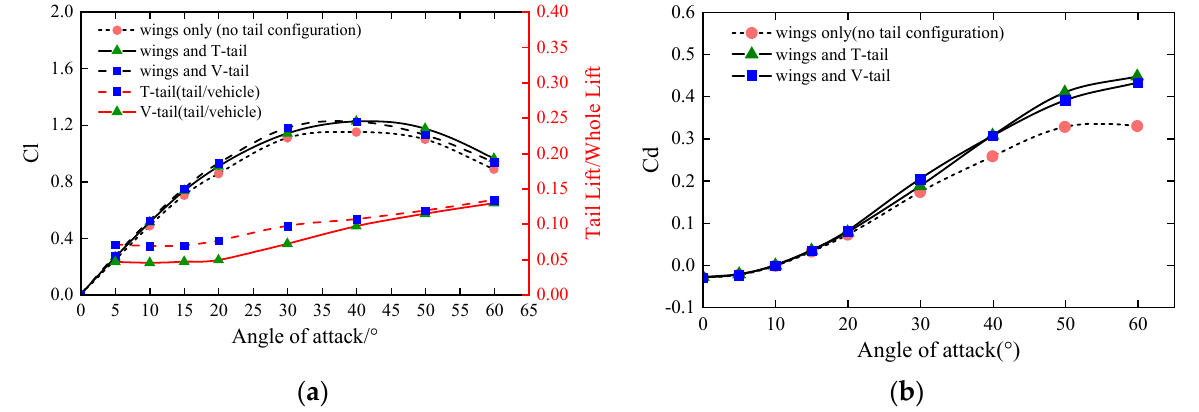
Figure 11. Flapping wing vehicle force characteristics. ( a ) Lift coefficient curve. ( b ) Drag coefficient curve.